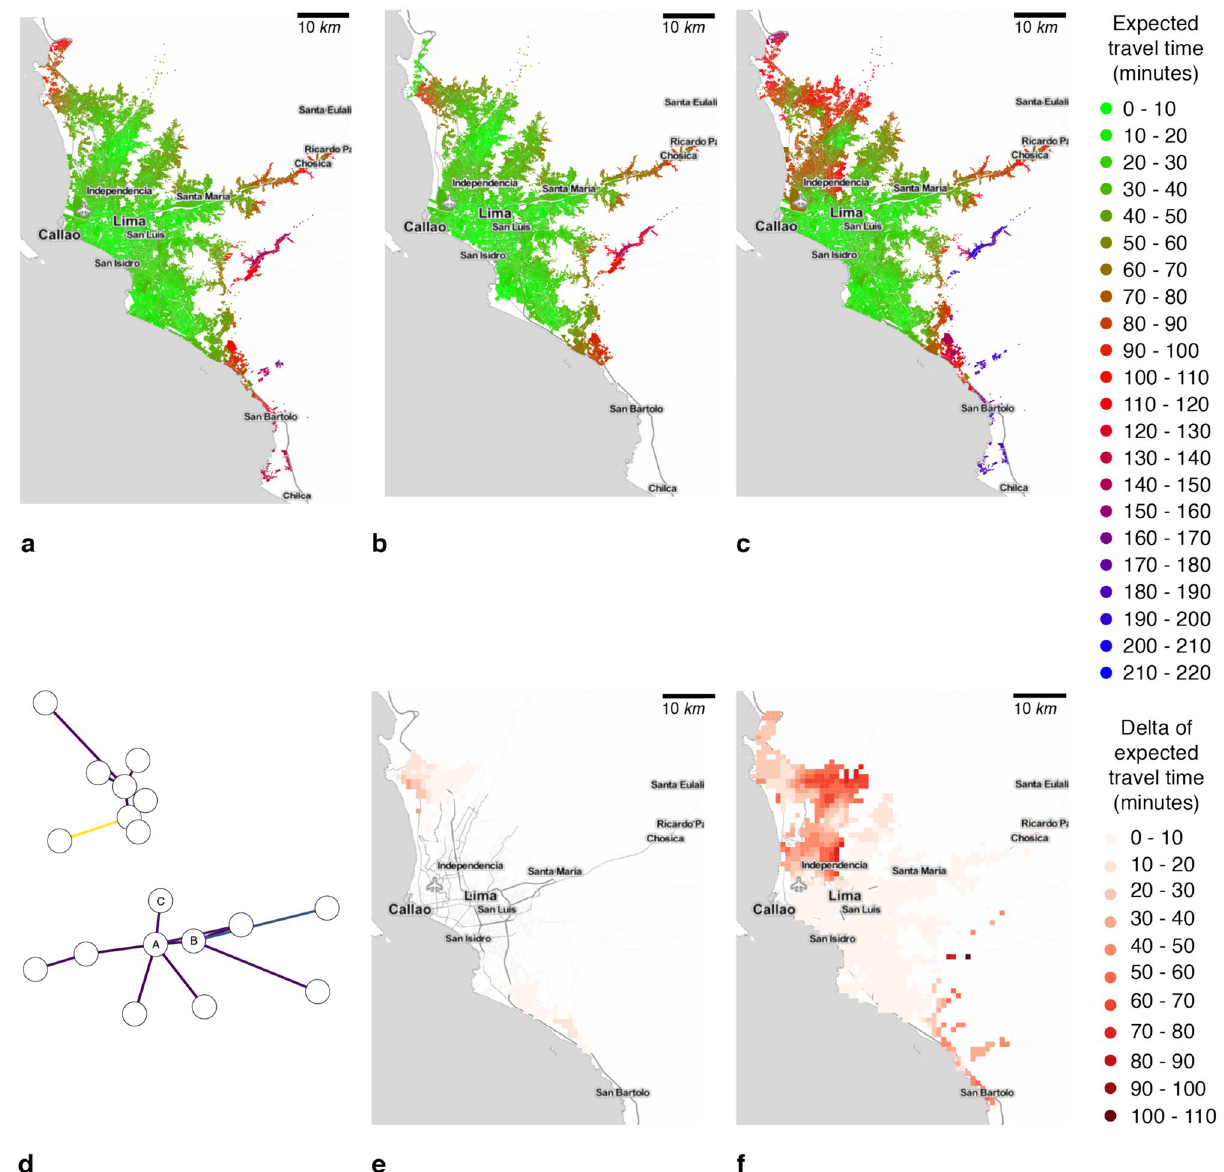
Figure 3. Accessibility map, at census unit scale, for healthcare facilities in Lima city. Where ( a ) is the undisrupted scenario, ( b ) is the earthquake scenario with a buffer of 500 m and a return period of 50 and 100 years, (c) is the flood scenario of flood planning hazard map at historical return period, ( d ) represents the number of nodes that shifted their preference from one healthcare facility to another as a graph, ( e ) is the heatmap of the accessibility difference between undisrupted and earthquake scenario with a return period of 50 and 100 years, and ( f ) is the heatmap of the accessibility difference between undisrupted and flood scenario of flood planning hazard map at historical return period, ( b ) shows an important accessibility time degradation in the north and in a small part in the south, ( c ) depicts a significant accessibility perturbation in the north of the city, and few changes in the south, ( d ) illustrates how healthcare provider preference change due to hazards, ( e ) shows an important accessibility time degradation in the north and in a small part in the south, ( f ) depicts a big accessibility perturbation in the north of the city and few changes in the south. Maps were created using Map Tiles by Stamen Design, CC BY 3.3 - Map data ©using Contextily 1.2.0 library for Python